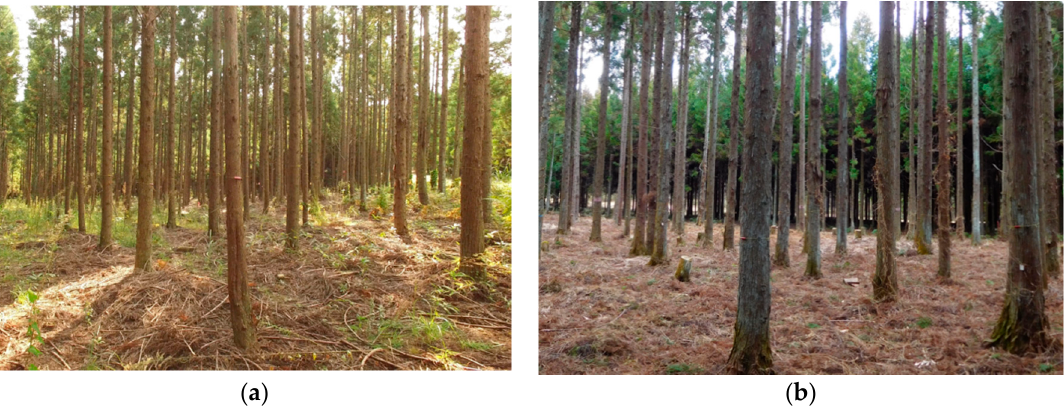
Figure 1. Pictures of the study sites. ( a ) Site 1; ( b ) Site 2.